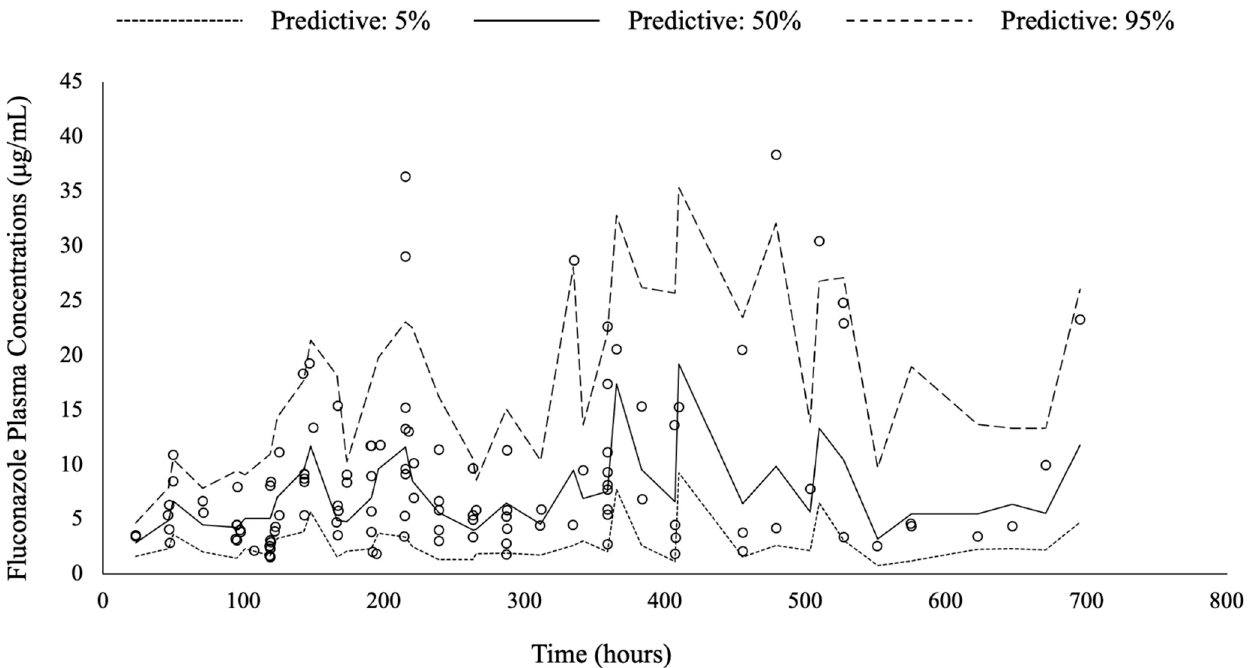
Figure 2. Prediction and variability corrected visual predictive check of final model. The black line at the center represents the median concentrations predicted, and the dotted black lines represent the 5th and 95th percentiles for the predictions. Each circle plot indicates the observed fluconazole plasma concentration.